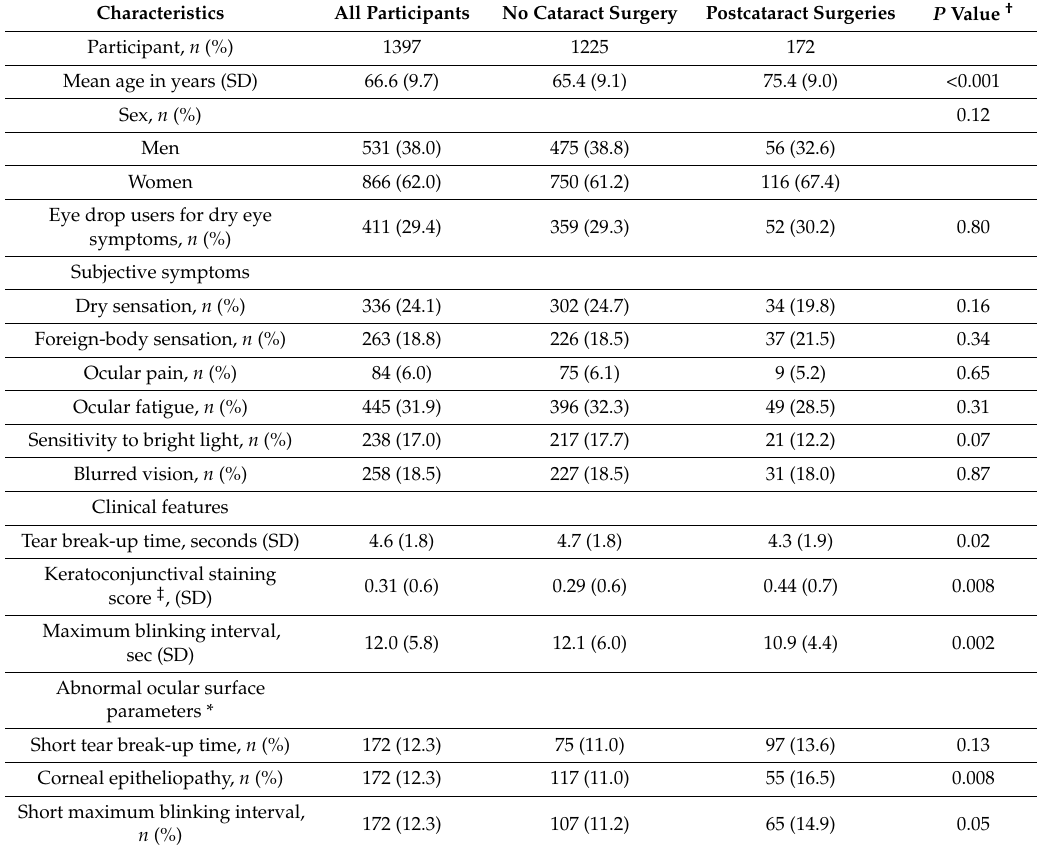
Table 1. Baseline demographic and clinical features of the study